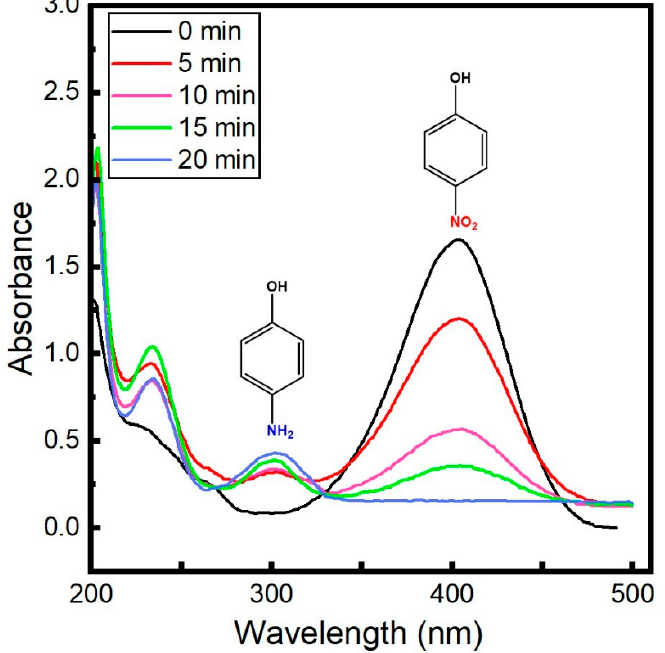
Figure 6. Scanning the UV–Visible spectra of PNP solution that catalytically reduces to PAP within 20 min.